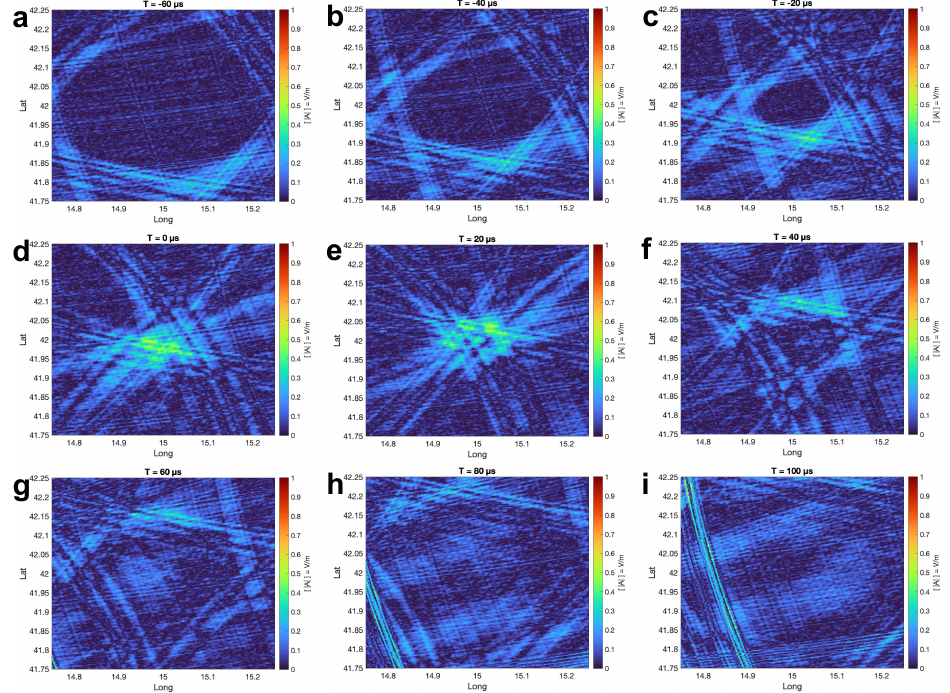
Figure 14. The scaled amplitude maps with a small receiver network with a simulated lightning location of 15°E and 42°S ( N =